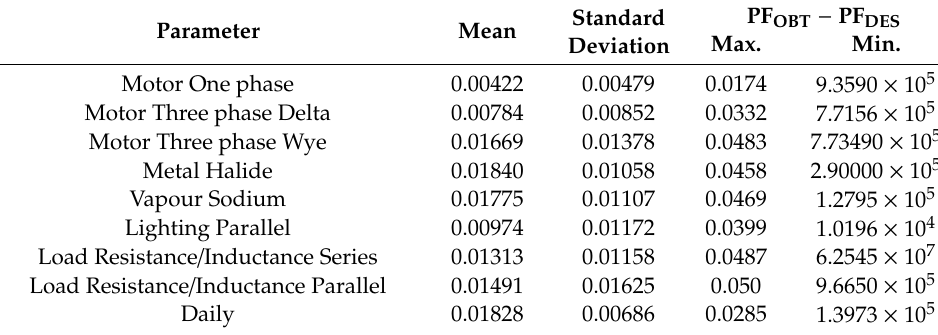
Table 7. Statistical results of objective function obtained by di ff erent loads con